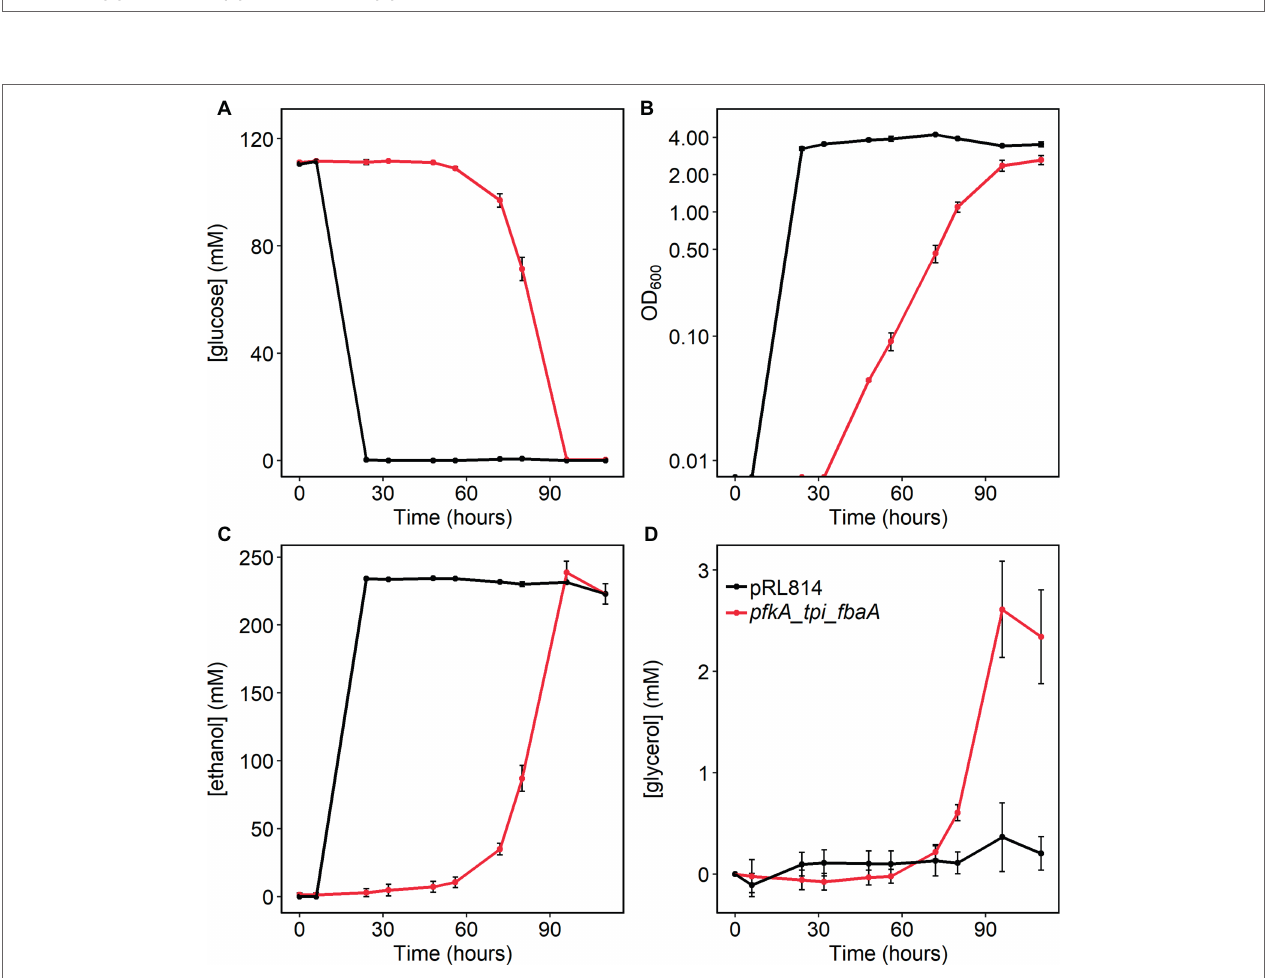
FIGURE 6 | (A) Glucose consumption, (B) growth (log scale), (C) ethanol production, and (D) glycerol production in Z. mobilis expressing Pfk I, Fba, and Tpi vs. the pRL814 control during anaerobic growth. Cells were grown statically in rich medium at 30 ° C. Cultures were inoculated from glycerol stocks made from fresh transformants and grown until stationary phase (110 h). Graphs show average and standard deviations from three biological replicates of Z. mobilis with pRL814 or Z. mobilis with pRL